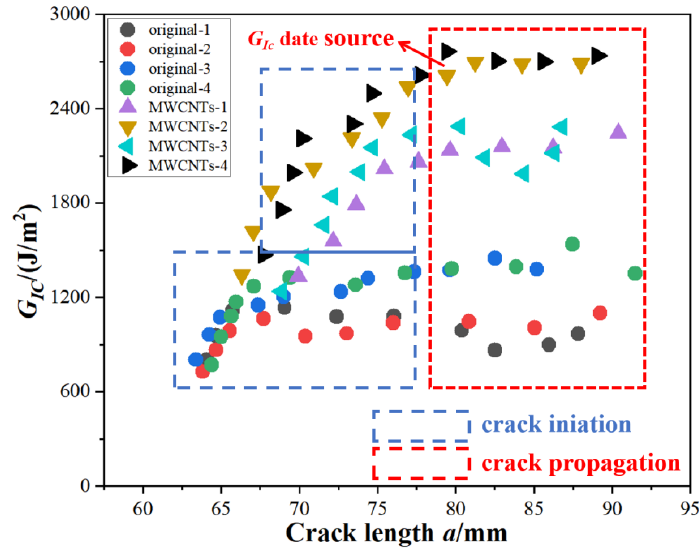
Figure 6. The G IC -a relational graph.